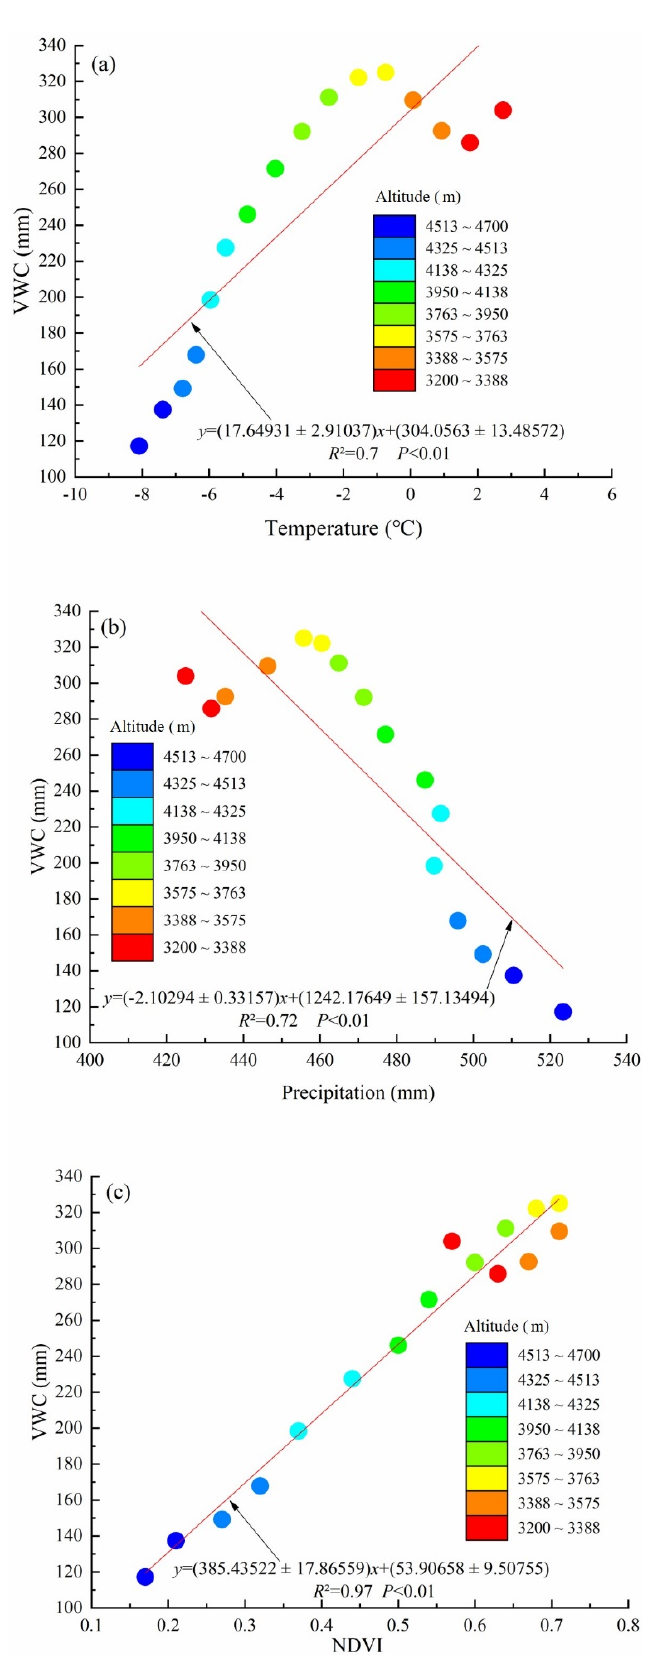
Figure 13. Linear relationships between annual average temperature ( a ), precipitation ( b ), NDVI ( c ), and VWC along the altitude gradient in the Qinghai Lake Basin from 2000 to 2014.